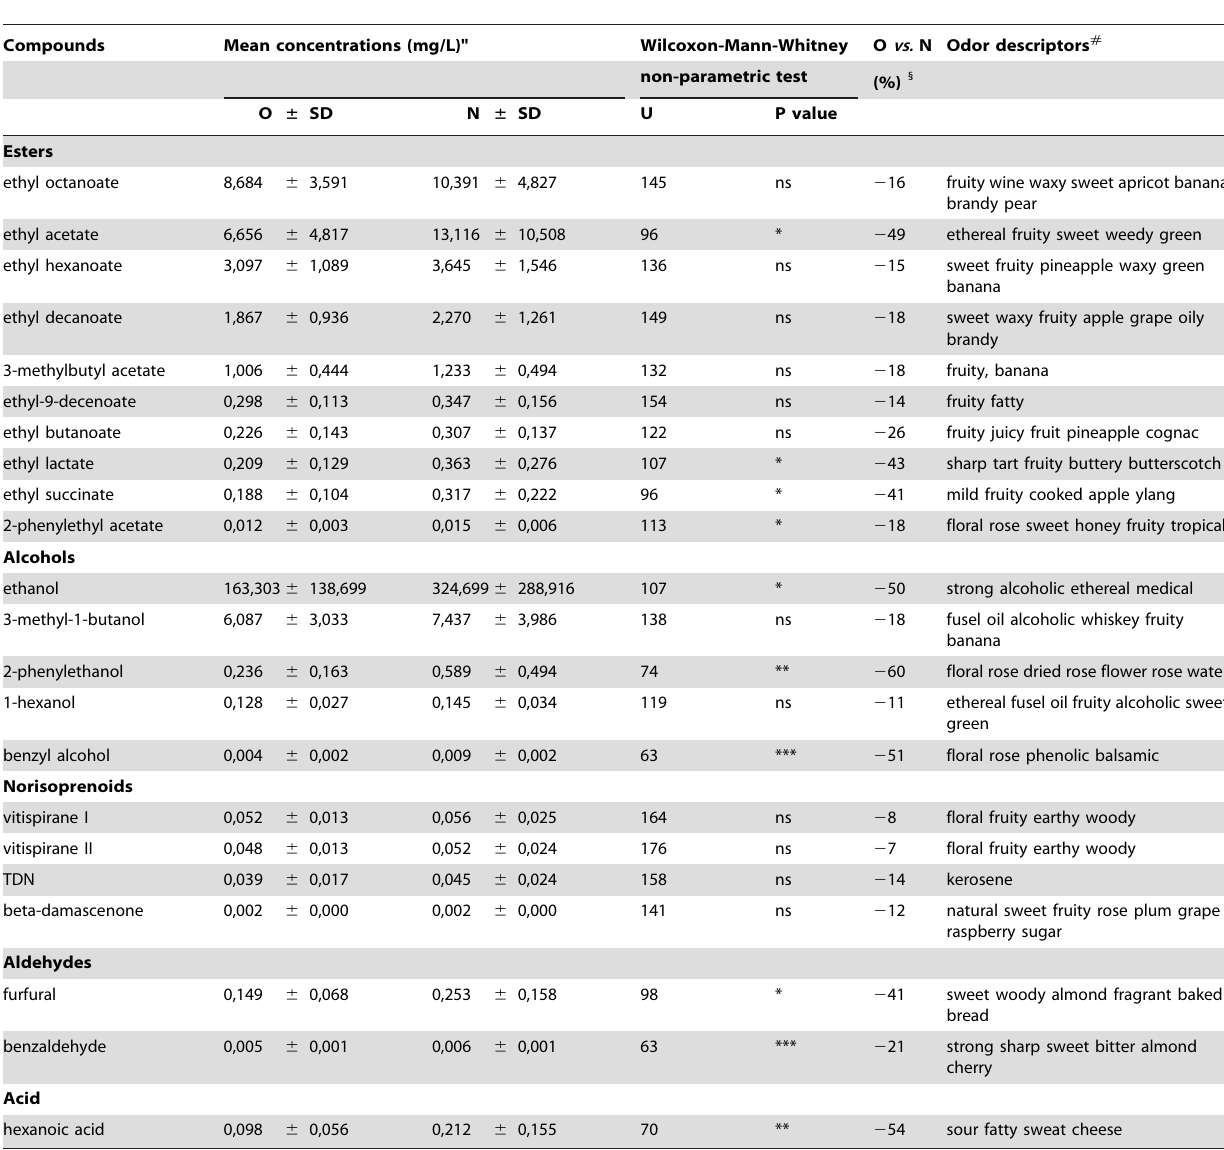
Table 3. Volatile compounds detected in the dynamic headspace of the white wine in the presence of saliva from obese and normal-weight